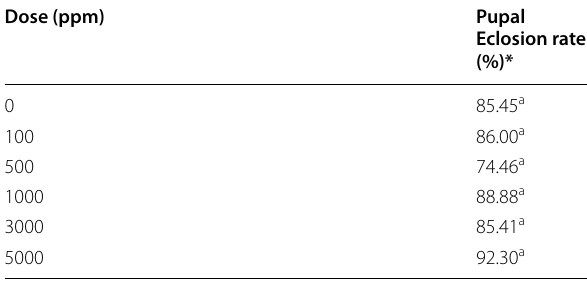
Table 3 Effect of zinc oxide NP on the pupal eclosion rates of G.